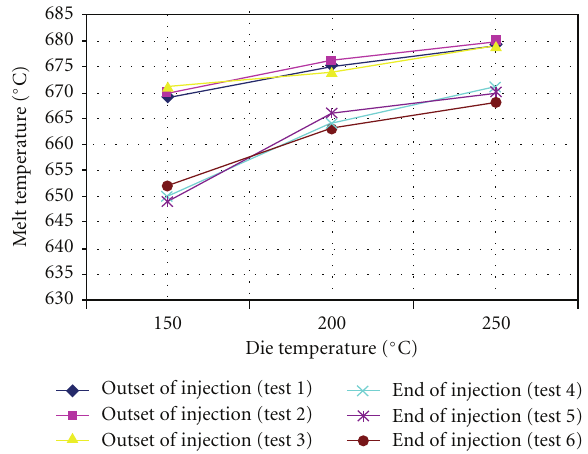
Figure 4: Reduction of melt temperature at various die temperatures at the initial and the end of injection.